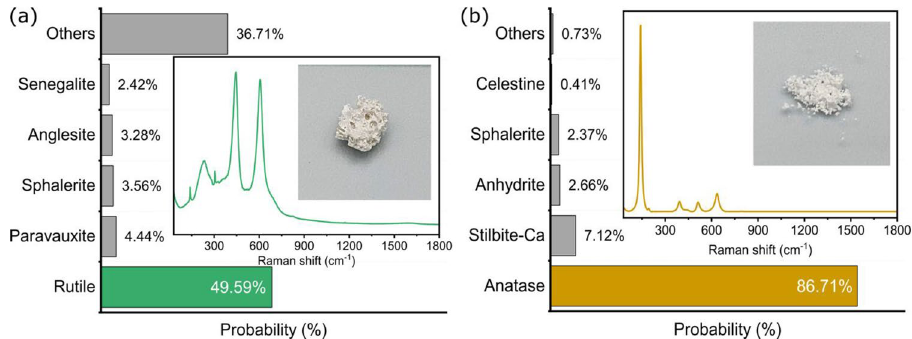
Figure 6. ( a ) The figure shows the response of the model to TiO 2 at 800 °C, below the 1100 °C temperature allowing full-conversion to rutile. The model still identifies rutile with a confidence of 49.59% suggesting an intermediate state with incomplete conversion. ( b ) The figure shows the response of the model to Degussa, P25. Degussa contains more than 70% anatase and around 20% rutile and amorphous compounds. The model can identify anatase with a lower confidence (86.71%). The Raman spectrum of the mineral and the image of the sample are presented to provide adequate context. The bar chart shows the top 5 predictions and the other predictions are combined as